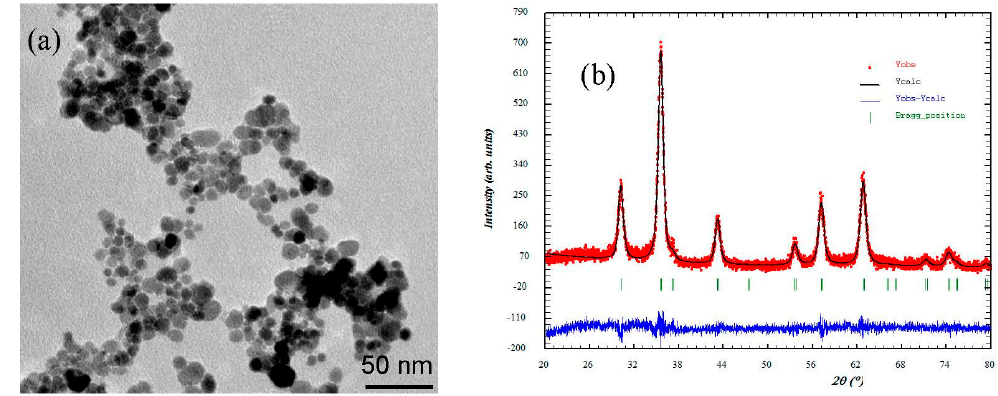
Figure 1. ( a ) Transmission electron microscopy (TEM) and ( b ) X-ray diffractogram adjusted by the Rietveld method of the Fe 3 O 4 - nanoparticles Rietveld method of the Fe 3 O 4 - nanoparticles (NPs).